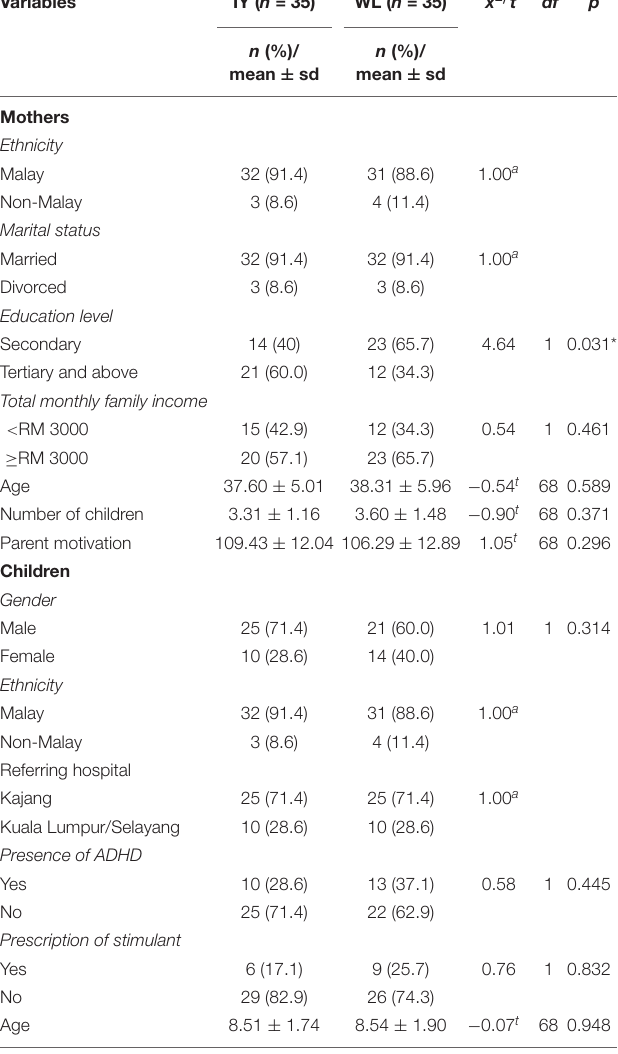
TABLE 1 | Baseline comparison of sociodemographic and clinical characteristics between IY and WL groups.